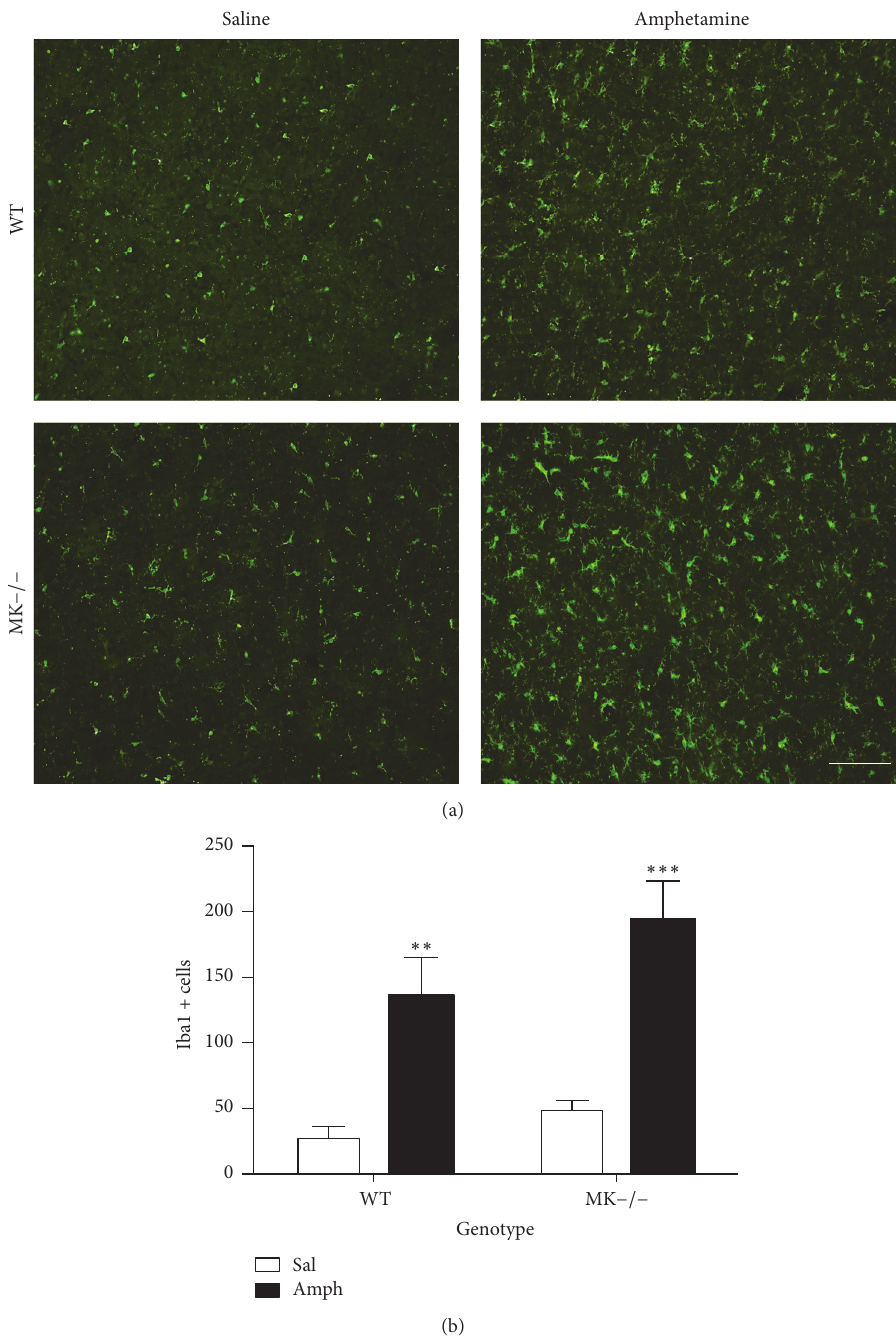
Figure 2: Amphetamine induces microgliosis in the striatum of WT and MK − / − mice. (a) Photomicrographs are from Iba-1-immunostained striatal sections of saline- (Sal-) or amphetamine- (Amph-) treated animals. (b) The graph represents quantification of data (mean ± SEM) obtained from the counts of Iba-1-positive cells in standardized areas of the striatum. Significant effects of the genotype ( F (1,10) = 4.597, 𝑃 < 0.0001 ) were found. ∗∗ 𝑃 < 0.01 and ∗∗∗ 𝑃 < 0.001 versus Sal. Scale bar = 200 𝜇 𝑃 = 0.05 ) and treatment ( F (1,10) = 46.12,